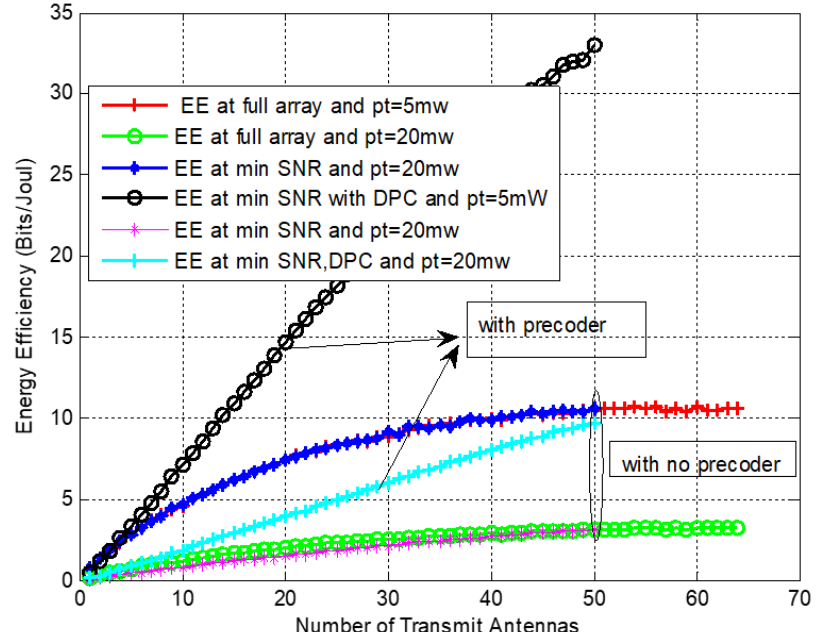
Figure 9. Energy efficiency evaluation as a function of number of BS antennas with at mmWave frequency, f = 38 GHz, and M =